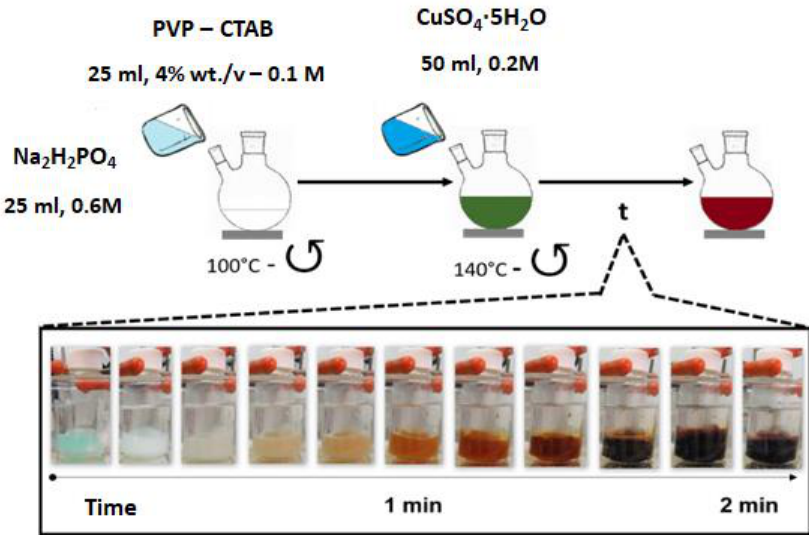
Figure 2. Schematic sequence of the di ff erent reaction steps in the solvothermal approach to obtain CuNPs using DEG as solvent.